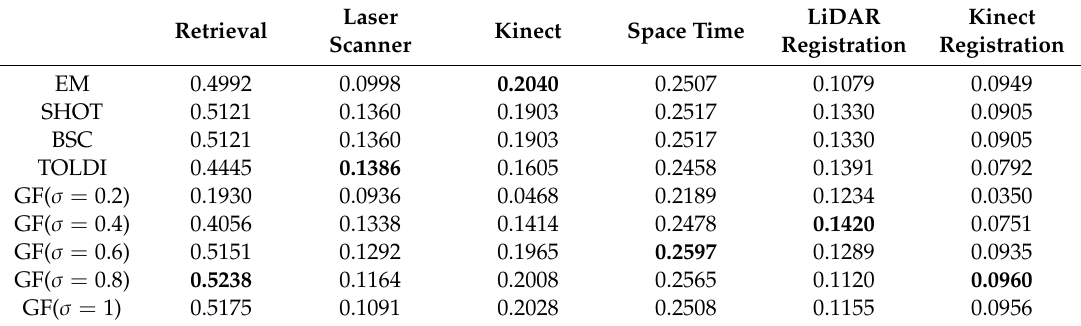
Table 2. Repeatability of the local reference frame (LRF) tested on the six datasets with di ff erent weighting methods. The best results are denoted in bold font for each dataset.